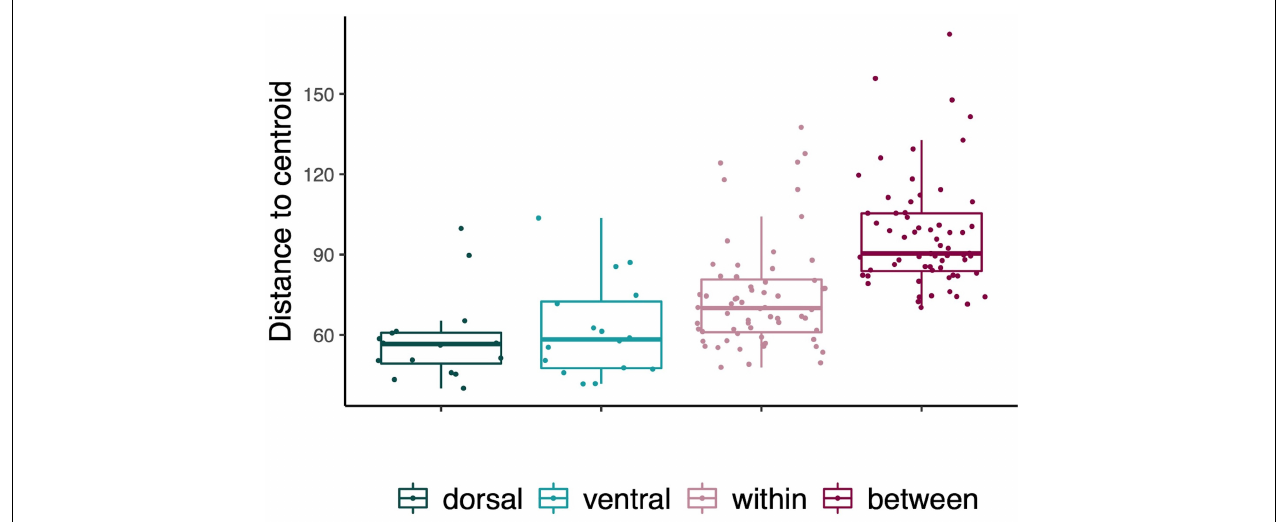
FIGURE 6 | Intra- vs. inter-individual comparisons of variation among samples of fish skin microbiomes. Variation among samples is measured as Euclidean distances to centroid. Dorsal (petrol blue) and ventral (turquoise) boxes display pairwise comparisons of replicated samples within individuals (mirroring right and left side from each body site, respectively). The estimates of variation within individuals (pink) are based on the four samples from each of the 16 individuals, and the estimates of variation among individuals (plum) are based on all samples from the 16 individuals together. All data points are shown. Box-plot elements: center line, median; box limits, upper and lower quartiles; whiskers, 1.5 × interquartile